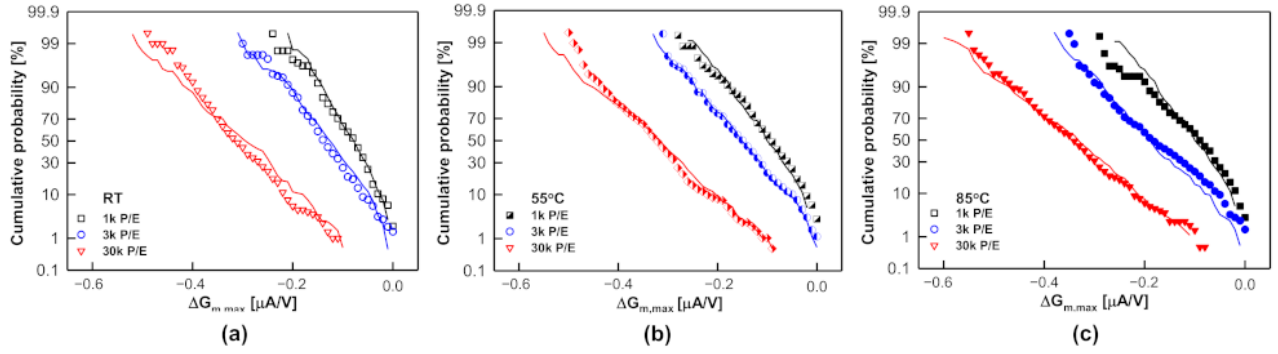
Figure 12. ∆ G m , max distributions for cells on WL15. Selected measured (symbols) and simulated (lines) at T cyc of ( a ) 25 °C, ( b ) 55 °C, and ( c ) 85 °C are shown. Reprinted from